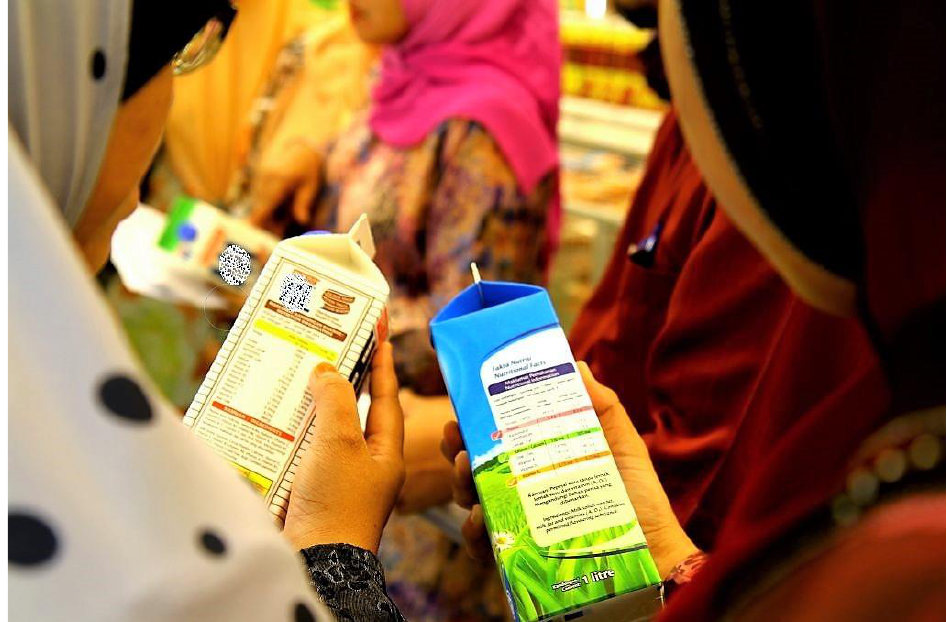
Figure 1. Understanding nutrition label reading during ‘Supermarket Tour and Sweep’ session.